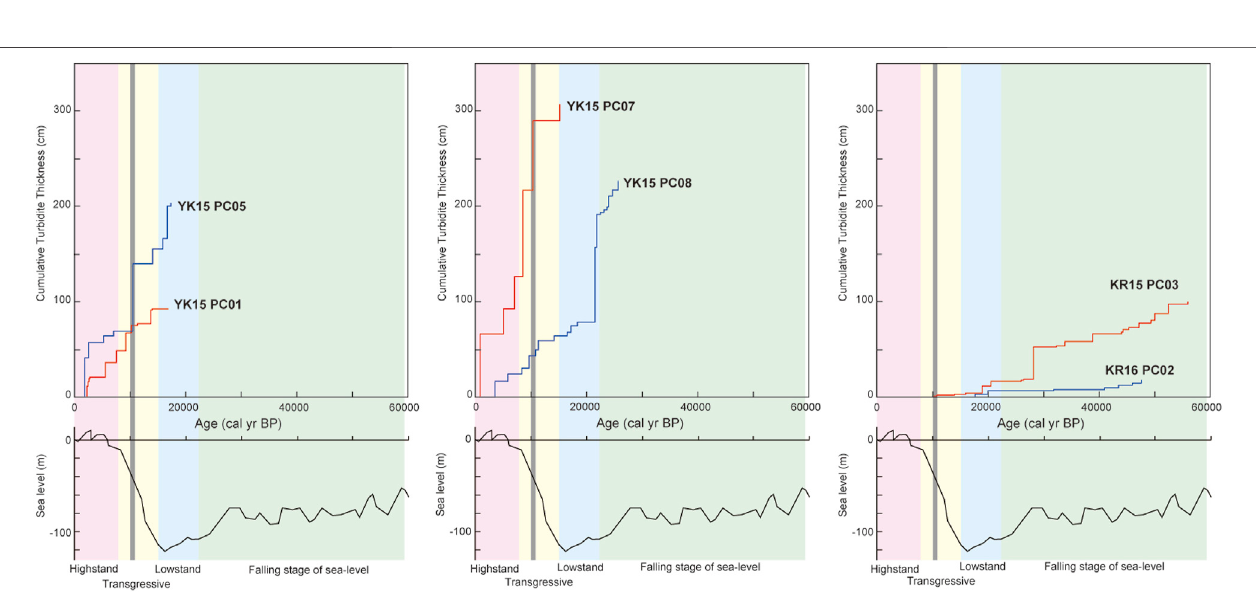
FIGURE4| TurbiditeaccumulationincoresYK15PC01andPC05onthesouthernpartofsubmarinefanatmouthofSC2(Kuroshima)submarinecanyon,incores YK15 PC07 and PC08 on the eastern part of submarine fan, in core KR15 PC03 near the mouth of SC1 (Hateruma) submarine canyon and in core KR16 PC02 near the mouth of SC4 submarine canyon. Sea-level curve and periods of depositional stages (highstand shown in pink, transgressive in yellow, lowstand in light blue and falling sea-levelstagein yellowish green) intheEast ChinaSea shelfare afterSaito etal.(1998). Grayband indicates onsetofthedevelopmentoftheHolocene coralreefs in the southern Ryukyu islands (Hori and Kayanne,